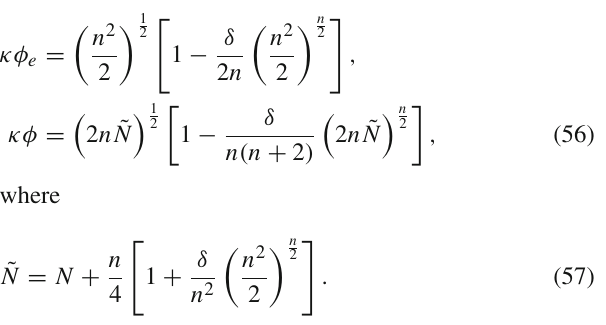
the δ max = 3 . 0094 × 10 − 2 value. Thus, the δ varies between zero and δ max . In the figure, the δ increases from red to blue is a slight increment, see the plot embedded in Fig.